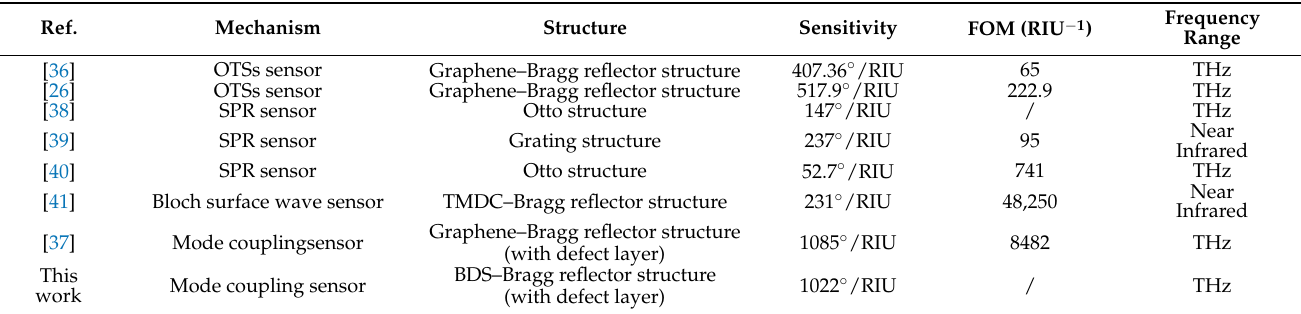
Table 1. Comparison between different refractive index sensing